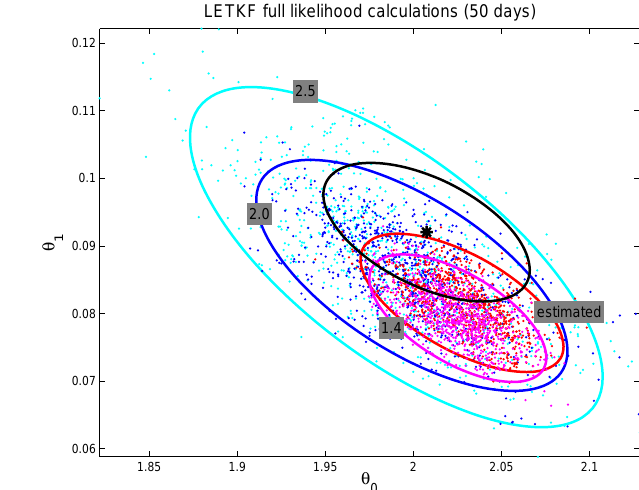
Fig. 9. The use of stochastic filtering method yields a noisy likeli- hood function. The results of 50 day run using EnKF based likeli- hood function is illustrated in the Figure. The values indicate nega- tive log-likelihood times two values. White star and black ellipse is acquired from correspondent EKF likelihood calculations.